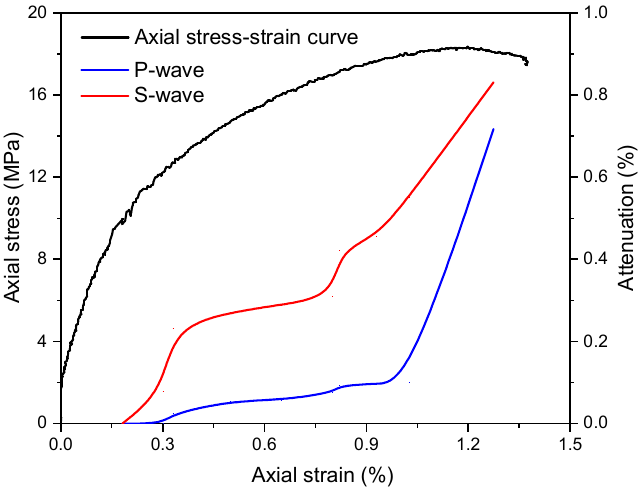
Figure 5. P- and S-waves’ velocity attenuations in sample SA-2 at different loading phases.